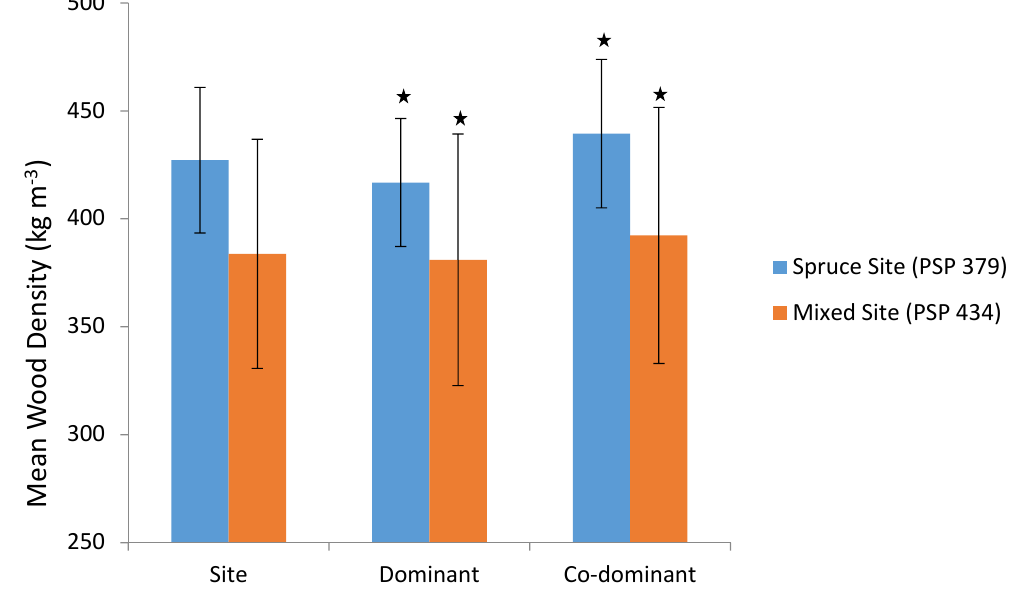
Figure 2. Mean wood density (kg·m − 3 ) for white spruce trees originating from a spruce site (PSP 379) and mixed site (PSP 434) by site and social classes. Error bars indicate standard deviation. Asterisk indicate significant differences ( α = 5%). n = 100 on the spruce site, while n = 50 on the mixed